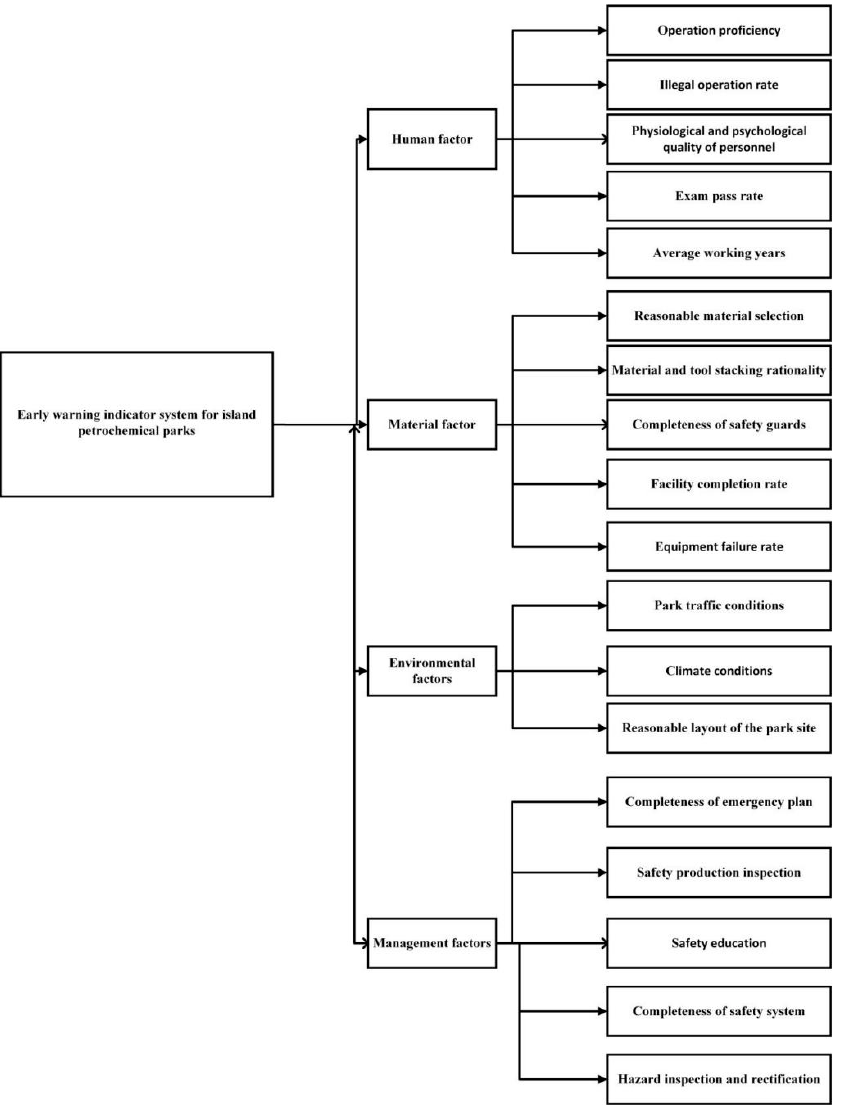
Figure 1. Early warning indicator system diagram.